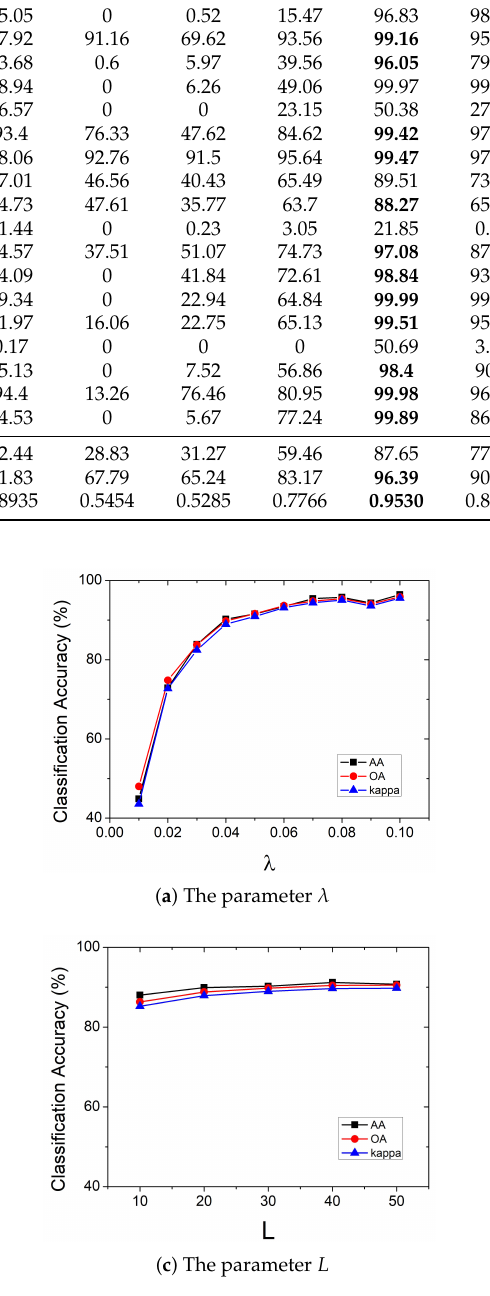
Figure 8. Influence of the parameters on the RF classification accuracies of the proposed method on the 2012 Houston